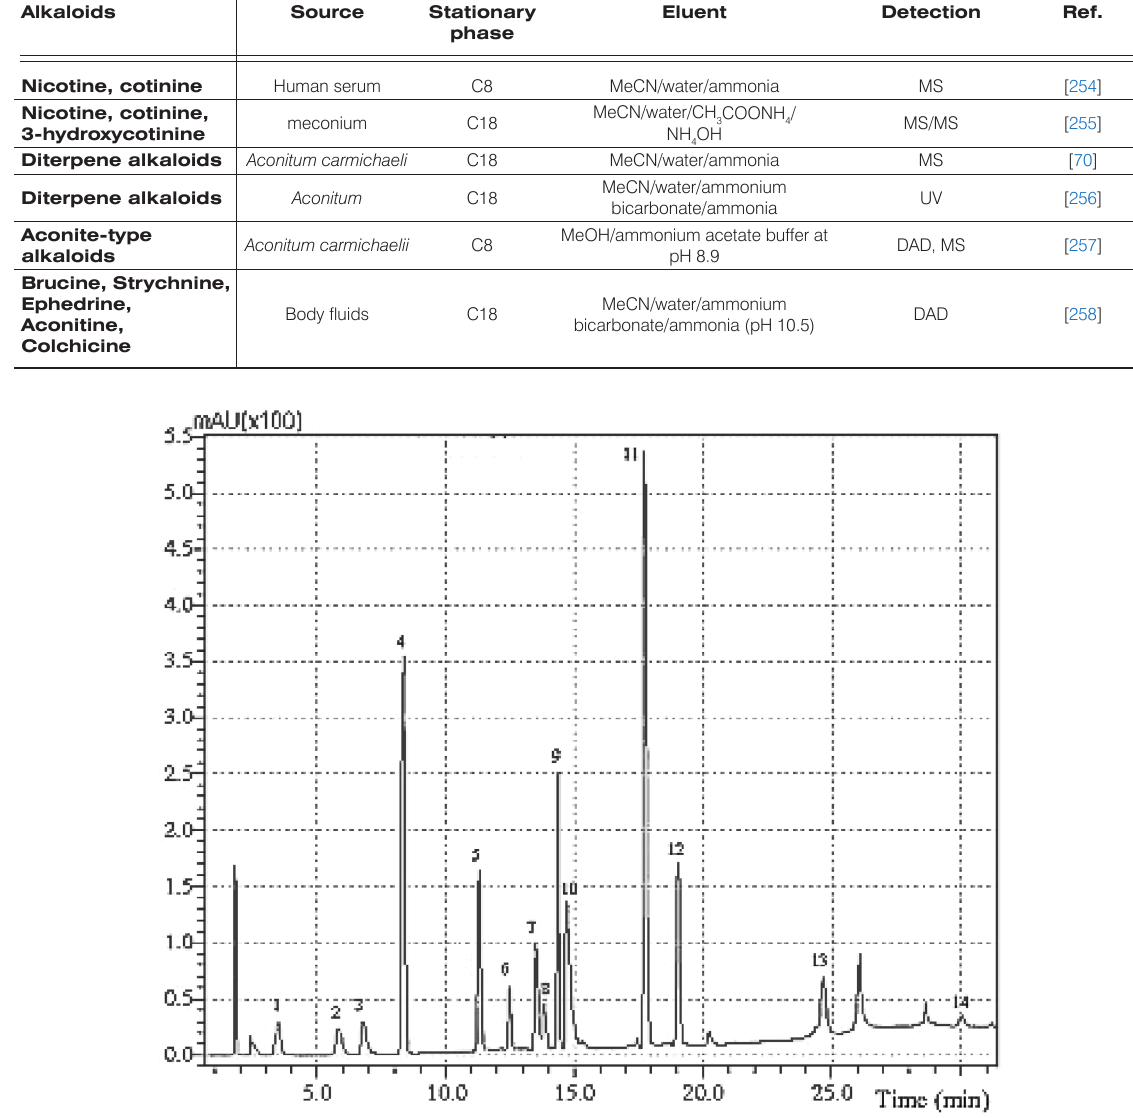
Figure 7. HPLC–UV standard chromatogram of the selected alkaloids in acetonitrile (1.0 lg mL -1 ) at 205 nm (1: cytisine, 2: anabasine, 3: nicotine, 4: cotinine, 5: codeine (IS), 6: scopolamine, 7: brucine, 8: atropine, 9: colchicine, 10: strychnine, 11: harmine, 12: